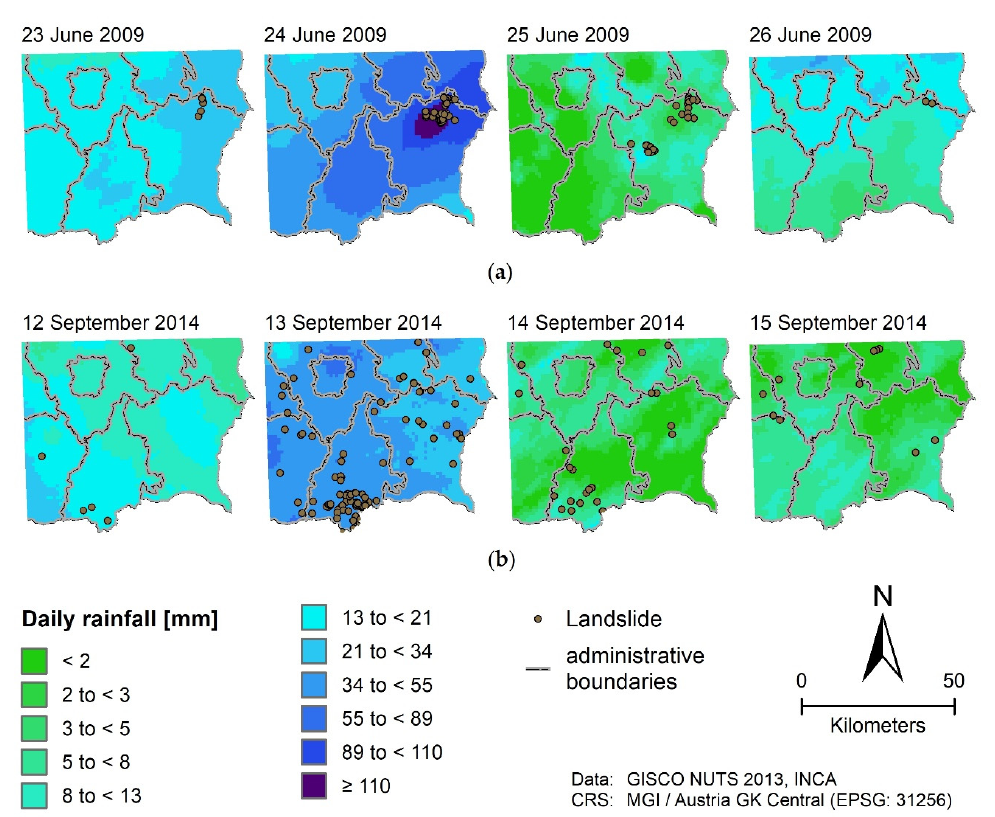
Figure A1. Total daily rainfall [mm] of days with landslide occurrences: ( a ) 2009 event; ( b ) 2014 event.